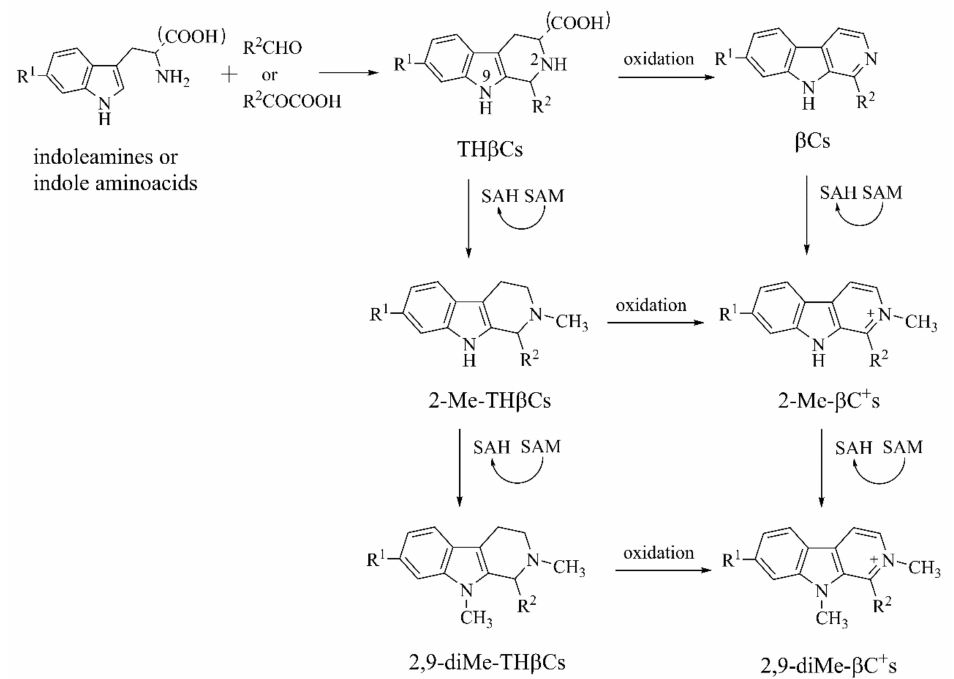
Figure 9. The biosynthesis and metabolism of β Cs [31,73,75]. Norharman and